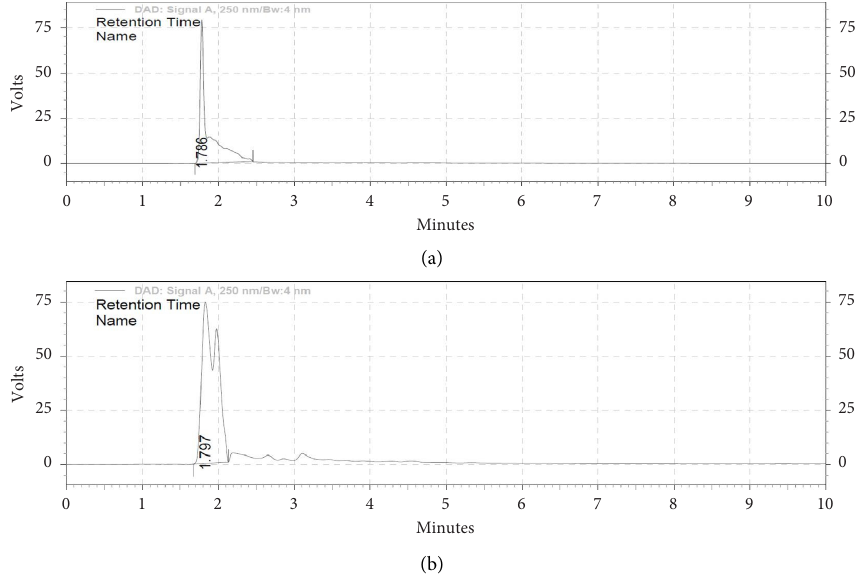
Figure 2: (a) HPLC of the 5-HT standard; (b) HPLC of the Ficus benjamina L.